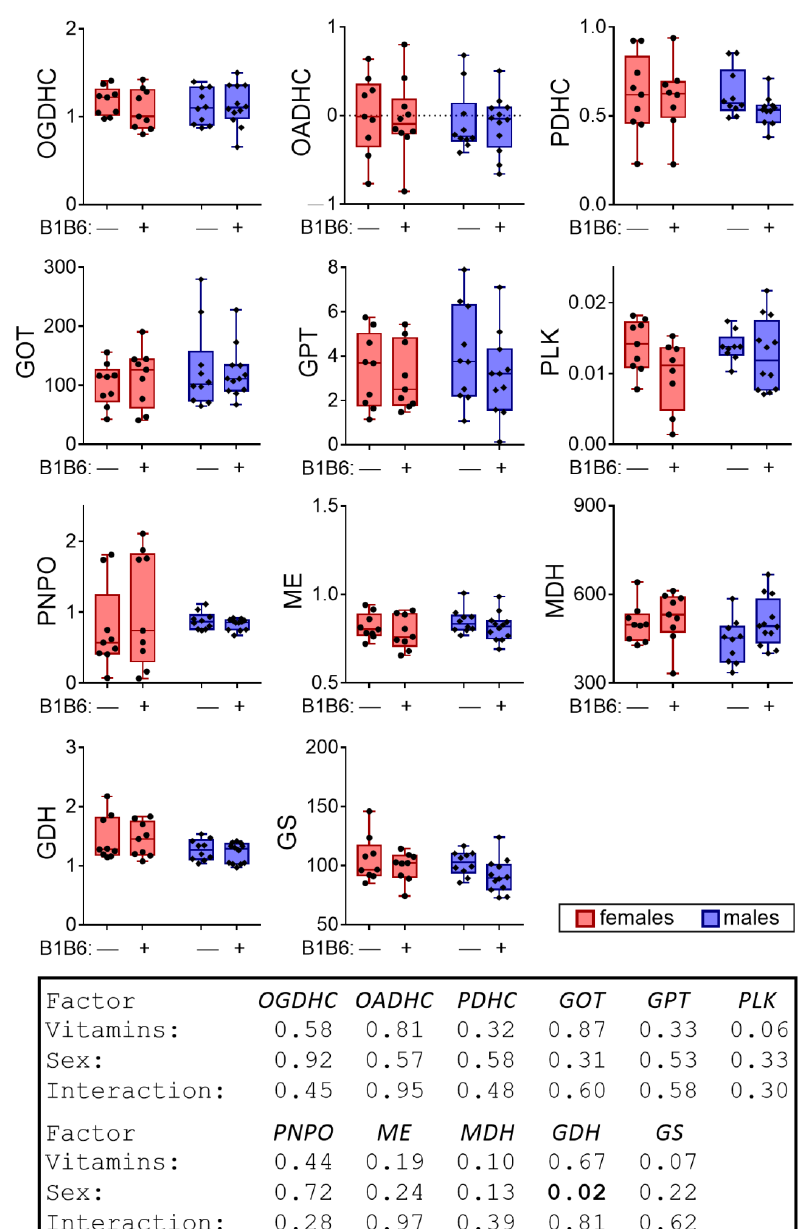
Figure 5. Effects of the administration of vitamins B1 and B6 on the activities of the cerebral cortex enzymes in the male and female rats the next day after the PTZ-induced seizure. The activities of enzymes are expressed in micromole/min per g of tissue, with the exception of the PNPO activity, expressed in nanomole/min per g of tissue. The statistical analysis of the data was performed by the two-way ANOVA with Tukey’s post hoc test (see Section 4).